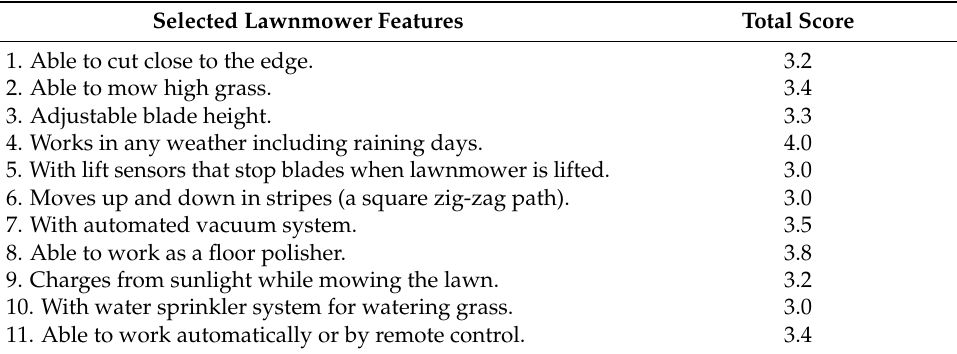
Table 11. List of selected key features with their respective total score. Selected Lawnmower Features